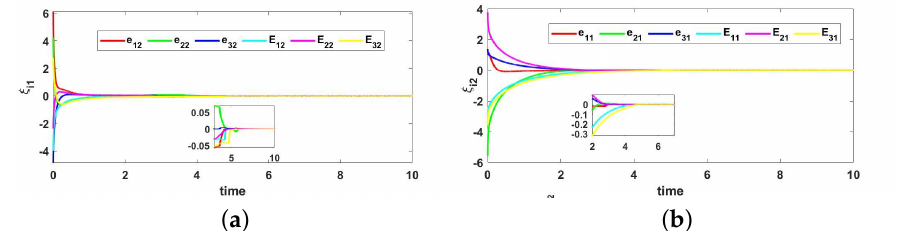
Figure 5. Formation tracking errors in Example 1. ( a ) formation tracking errors of ξ i 1 ; ( b ) formation tracking errors of ξ i 2 .